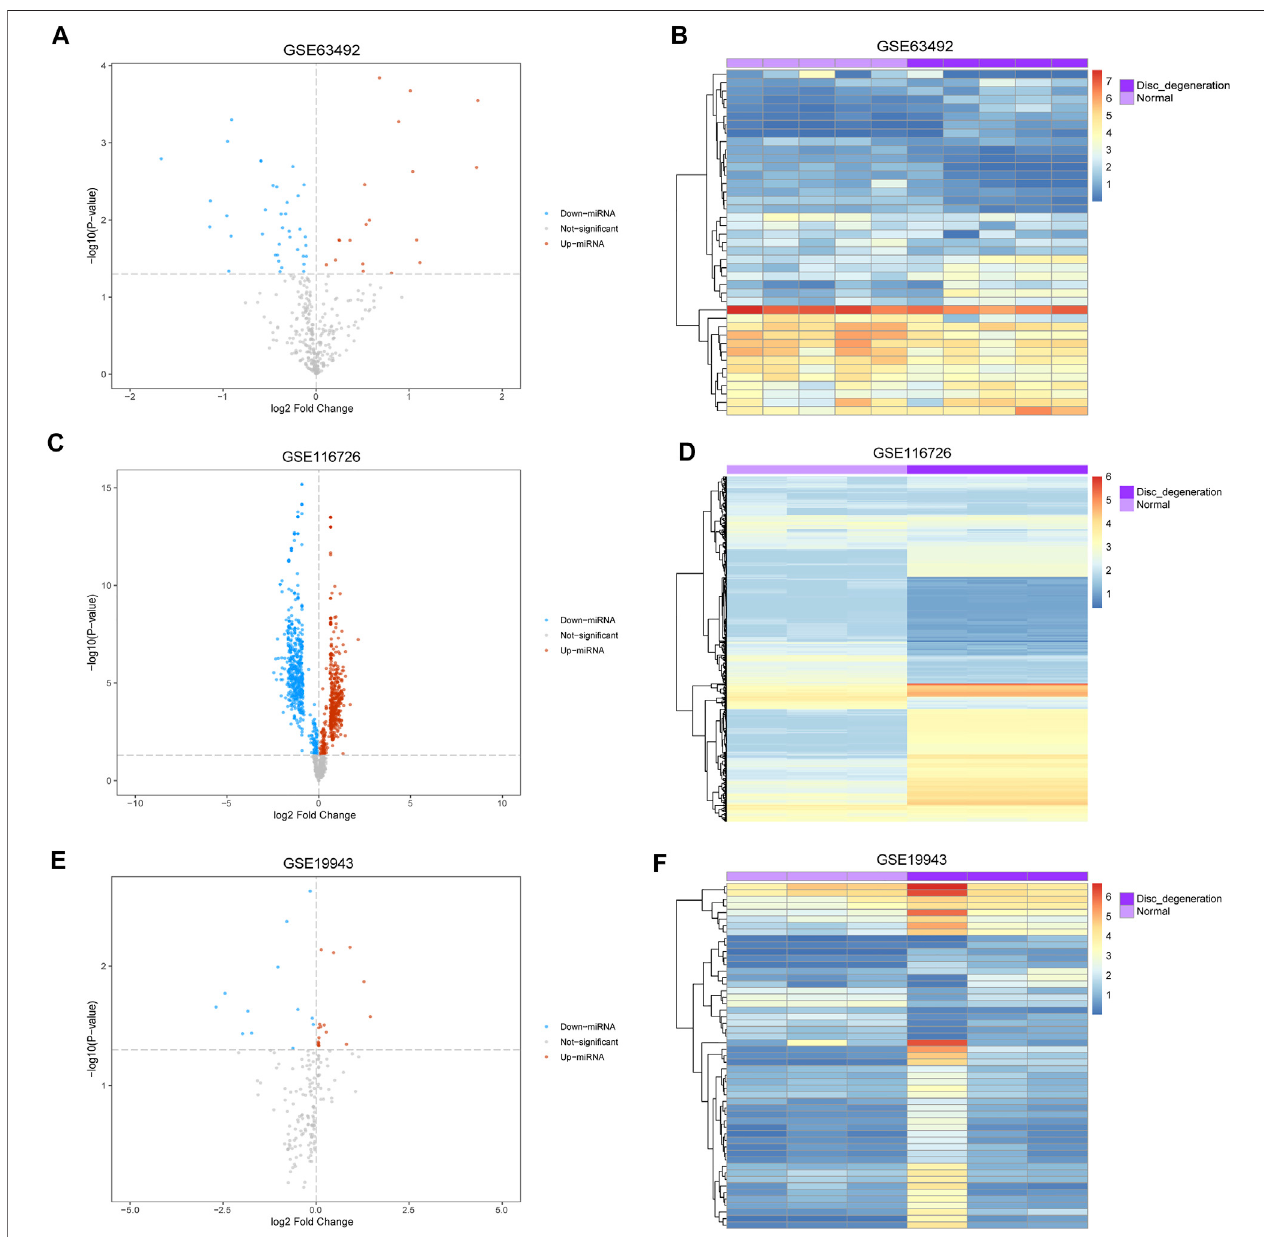
FIGURE 3 | Differentially expressed miRNA associated with disc degeneration. (A,C,E) Volcano map of differentially expressed genes. The abscissa represents log2-fold Change, and the ordinate represents -log10 ( p -value). The red node indicates upregulated differentially expressed genes, the blue node indicates downregulated differentially expressed genes, and the gray node indicates genes that are not signi fi cantly differentially expressed. (B,D,F) Heatmap of differentially expressed genes. The abscissa represents the patient ID, and the ordinate represents the respective differentially expressed genes with red indicating high gene expressionandblueindicatinglowgeneexpression.Thedarkpurplecommentbarindicatesthedegenerativedisctissue,andthelightpurplecommentbarindicatesthe normal disc